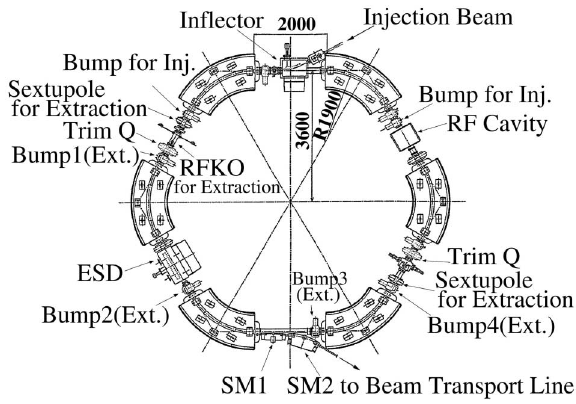
FIG. 1. Proposed compact proton synchrotron.